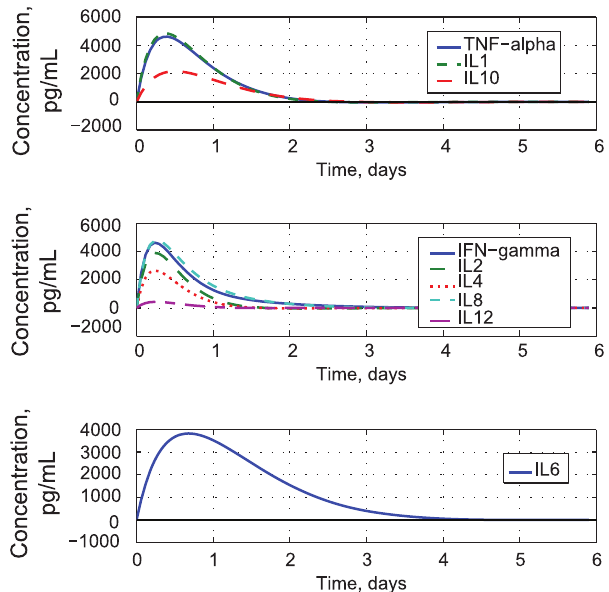
Figure 9. Modeled time histories of the three cytokine response groups with experimentally derived initial rates of change.